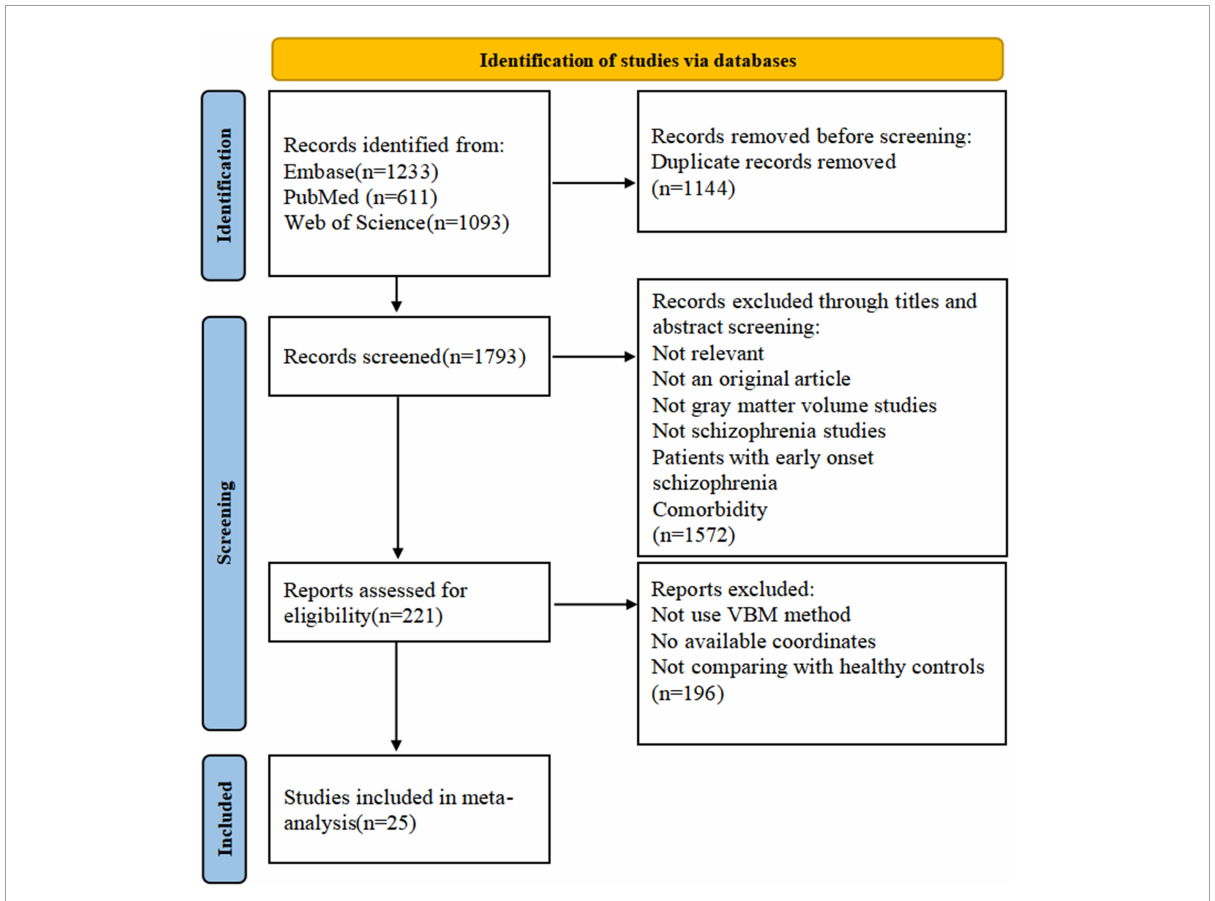
FIGURE1 The flowchart for identifying studies in this meta-analysis.